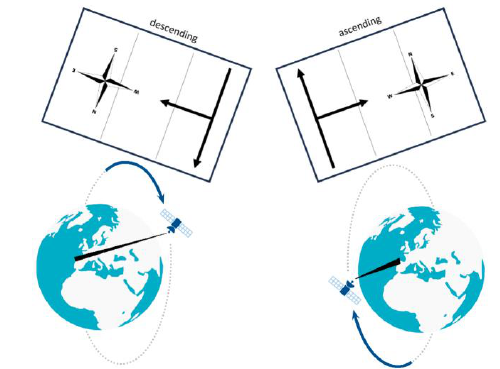
Figure 4 . Difference between the capture geometry in the result of a descending orbit versus an ascending orbit.